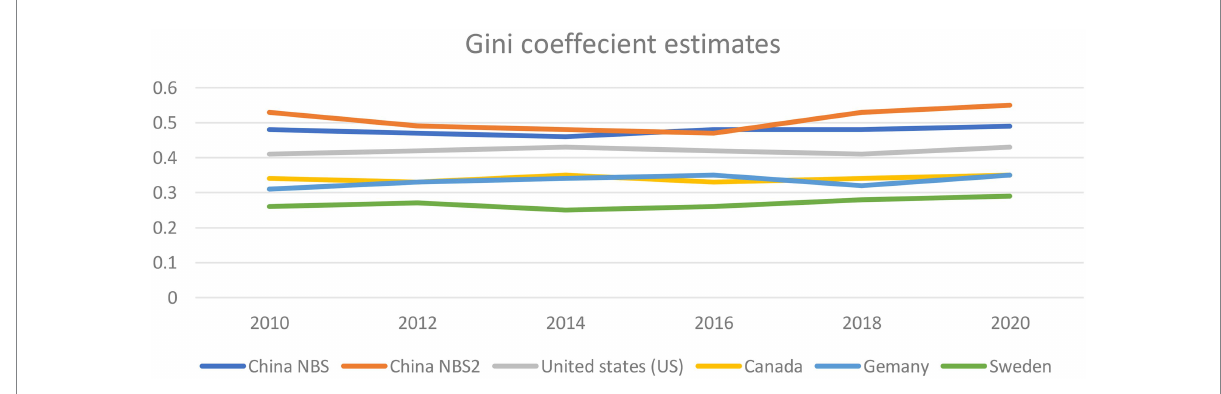
FIGURE 1 China’s inequality is on the rise, estimated by the Gini coefficient. Source: National Bureau of Statistics of China and National Bureau of